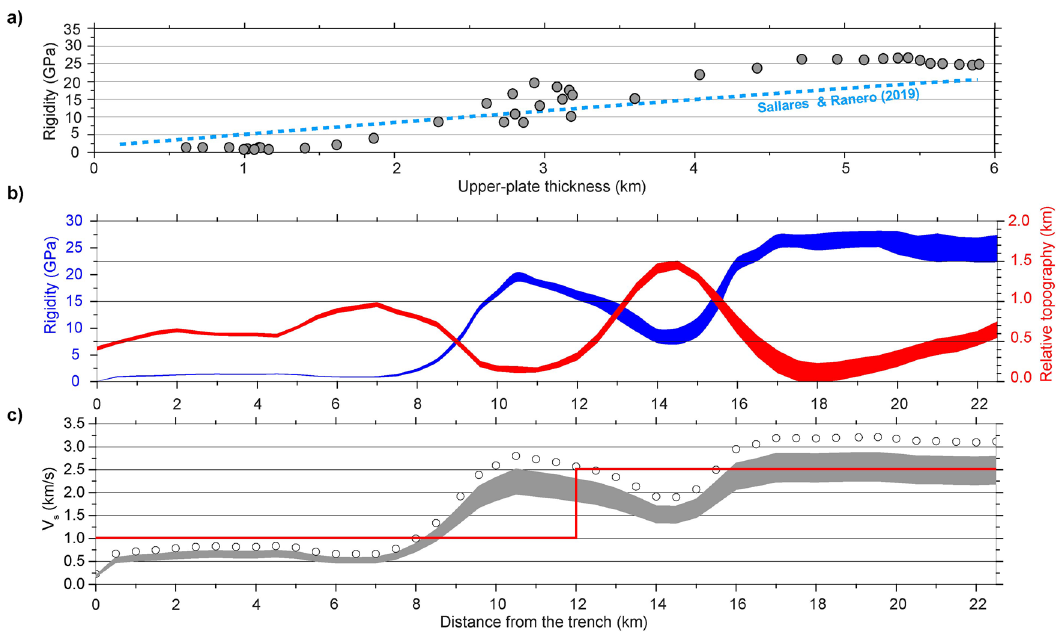
Fig. 4 Interplay between upper-plate elastic rock properties and interplate morphology. a Rigidity at the base of the upper plate as a function of upper- plate thickness along our model (grey circles) compared with the global depth distribution from ref. 7 . b Rigidity (Blue band) at the base of the upper plate as a function of distance from the trench compared with the relative topography of the interplate (red band). The latter was obtained by removing the landward dipping trend of the interplate and calculating the difference between the inverted re fl ector and a 7°-landward-dipping fl at re fl ector. The thickness of each curve depicts the range of uncertainty derived from Monte Carlo inversion. c V s (white dots) and the corresponding rupture velocity ( V r ; grey band) at the base of the upper plate as a function of distance from the trench. V r is calculated assuming that earthquakes propagate between 70 and 80% of V s 43 . The upper and lower bounds of the grey band correspond to 80 and 70% of the model V s , respectively. The red solid line depicts the average value of V r within a 12-km-wide